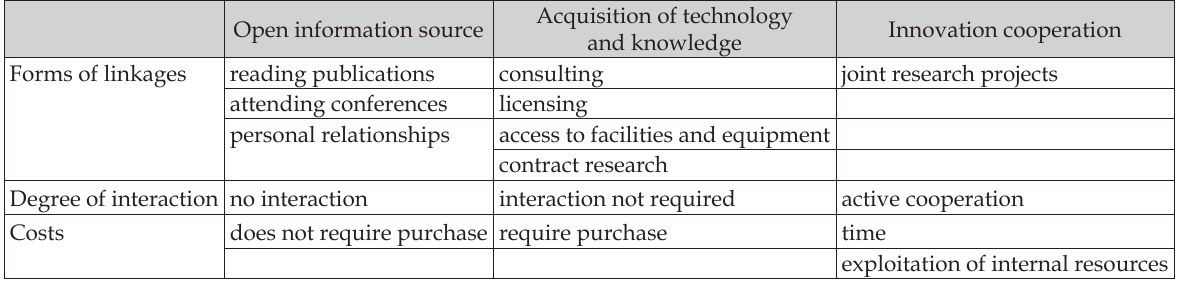
Table 1. Types of linkages, degree of interaction and costs of HEI-firm